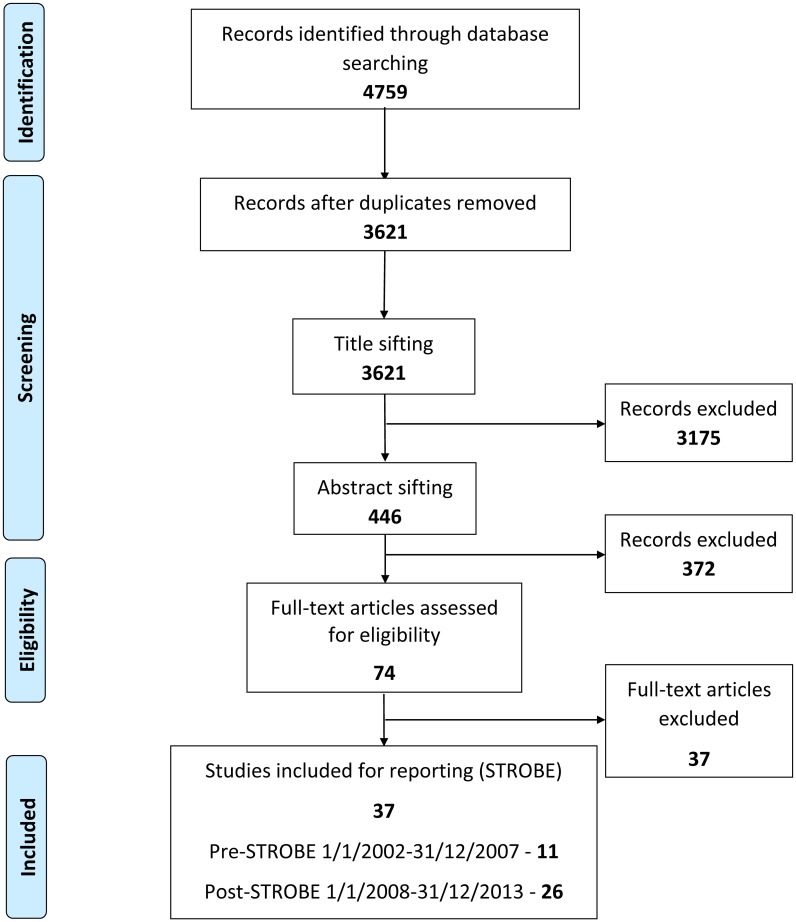
PRISMA flow diagram.